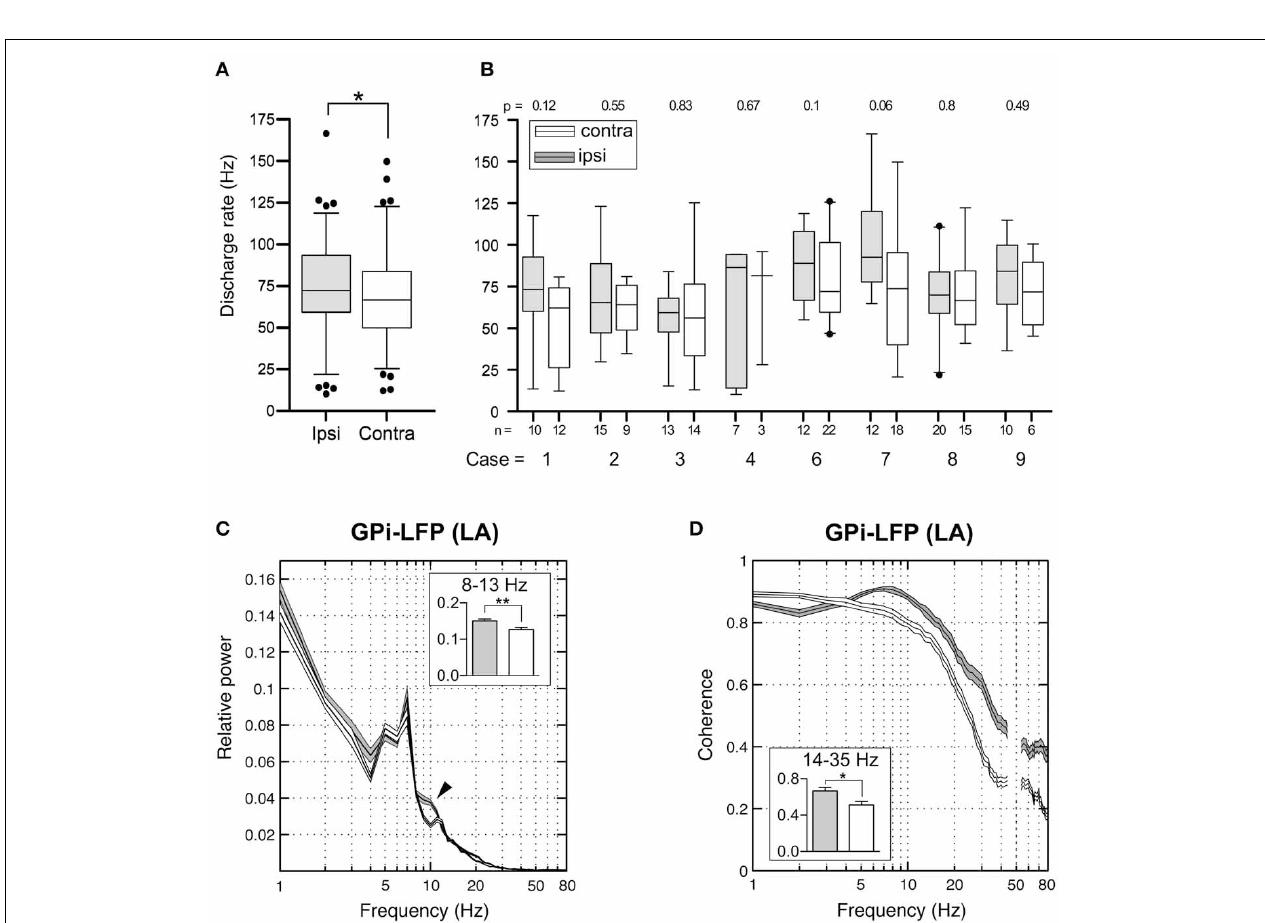
FIGURE 10 | Scatterplots of pallidal discharge rates as a function of demographic and clinical variables. Data points in both graphs represent mean firing rates for each patient (pooled from recordings in both